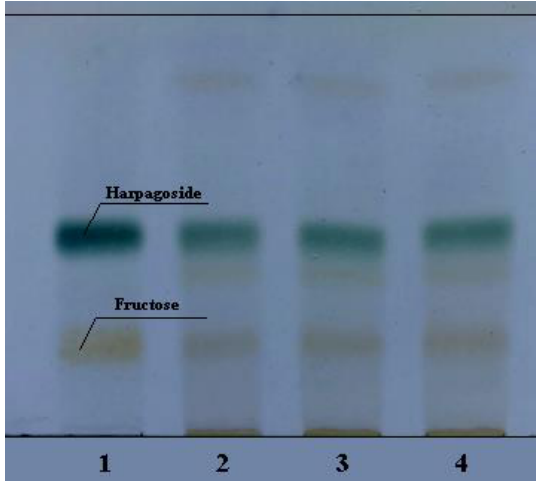
Fig. 2. Chromatogram in daylight, obtained under the conditions described in the SPhU 2.2 and Ph. Eur.